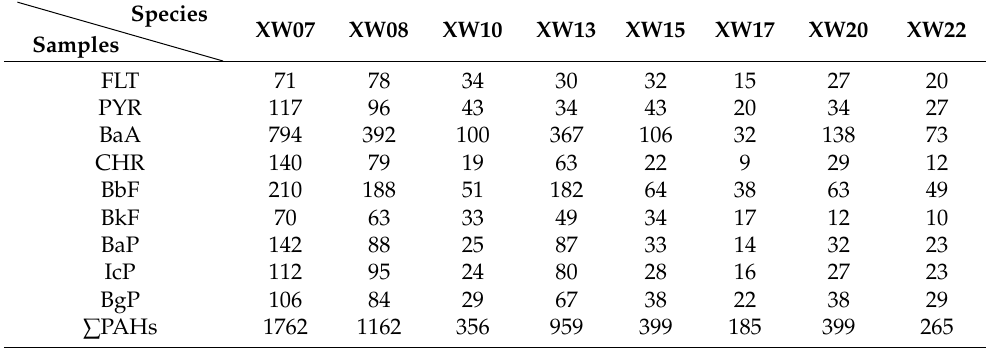
Table 4. Average mass concentrations (ng/m 3 ) of PAHs in the PM 2.5 samples from homes in the Hutou village of the Xuanwei